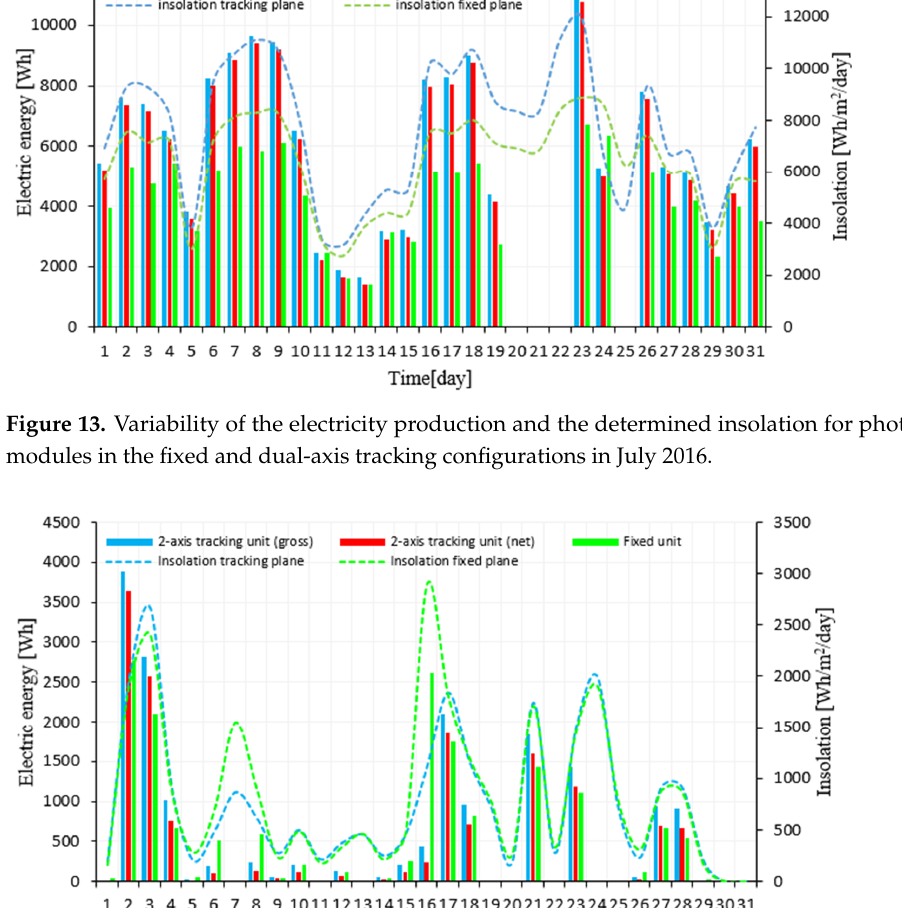
for a two-year measuring period and insolation recorded on both planes.